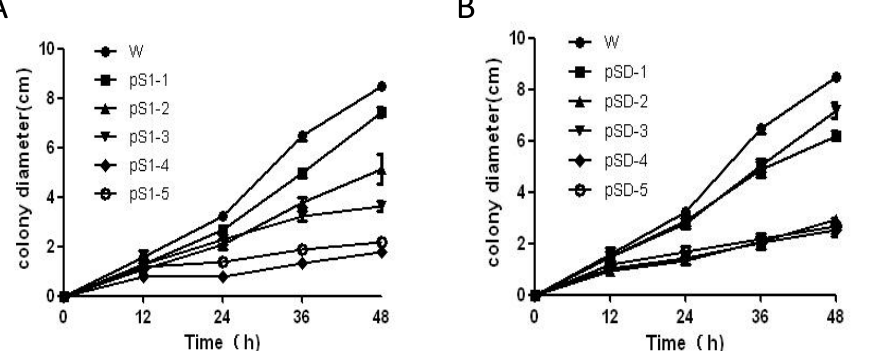
Figure 5. Determination of wild-type and radial growth in SsMADS -silencing transformant strains cultivated on PDA solid medium and incubated for 2 days at 25 °C. ( A ) Radial growth determination of the wild type strain (W) and the transformants pSl-1 to pSl-5; ( B ) Radial growth determination of the wild type strain (W) and transformants pSD-1 to pSD-5. A B